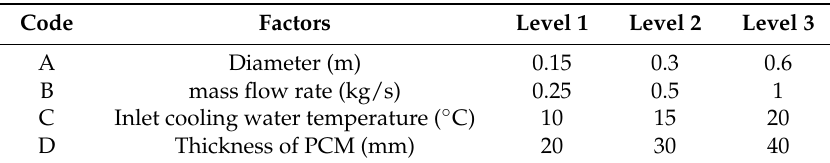
Table 8. Parameters and corresponding levels.